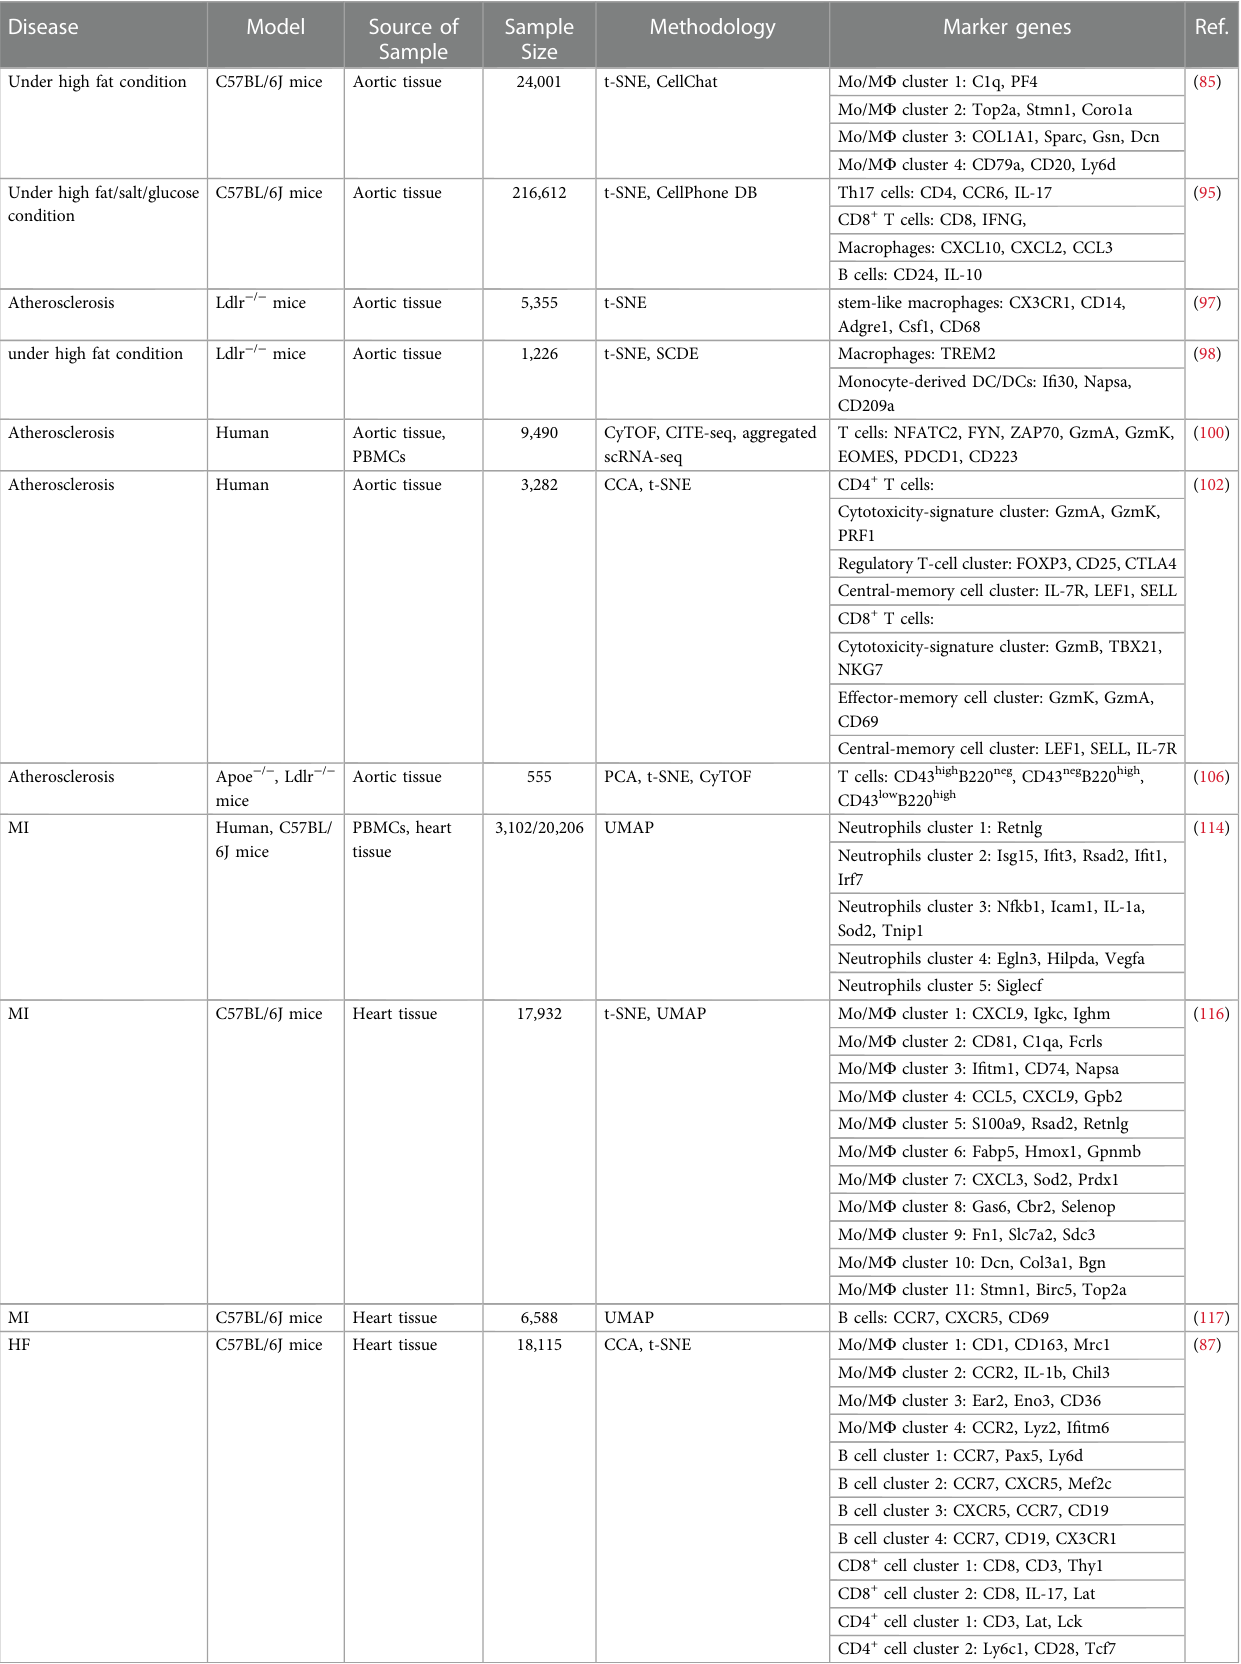
TABLE 1 Renewed phenotype marker genes of immune cells via single-cell RNA